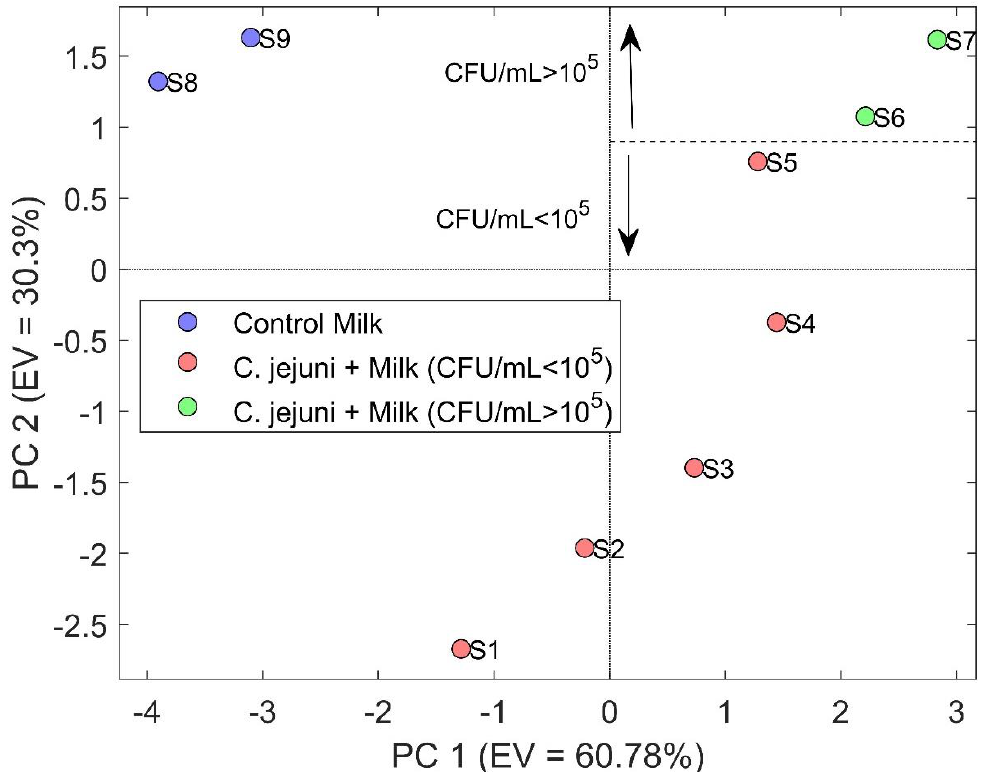
Figure 3. PCA score plot representing the data obtained during the first 7 h of the second set of analysis. The horizontal axis represents the explained variance enclosed in PC1 as equal to 60.78%, conversely, the vertical axis represents the explained variance enclosed in PC2 as equal to 30.30%. The total explained variance enclosed in the graphic is equal to 91.08%.